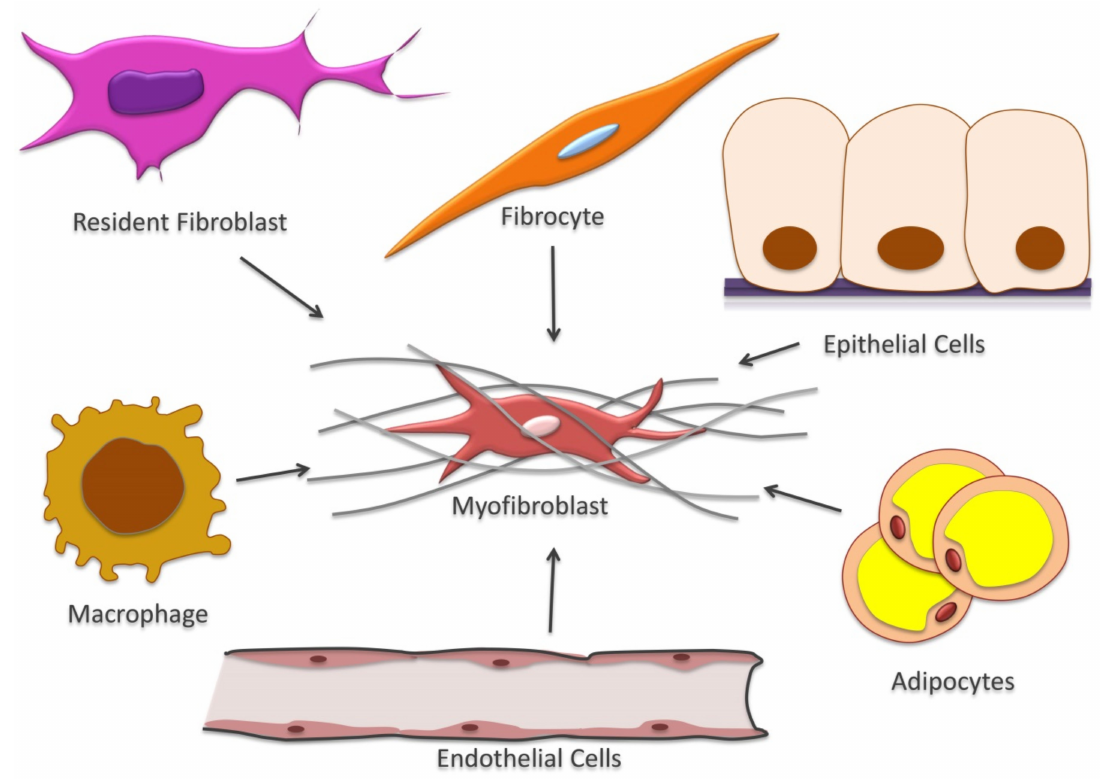
Figure 2. Myofibroblasts multicellular origin. Myofibroblasts can originate from diverse cell population as resident fibroblasts, fibrocytes, adipocytes, monocytes, mesenchymal cells and epithelial/endothelial